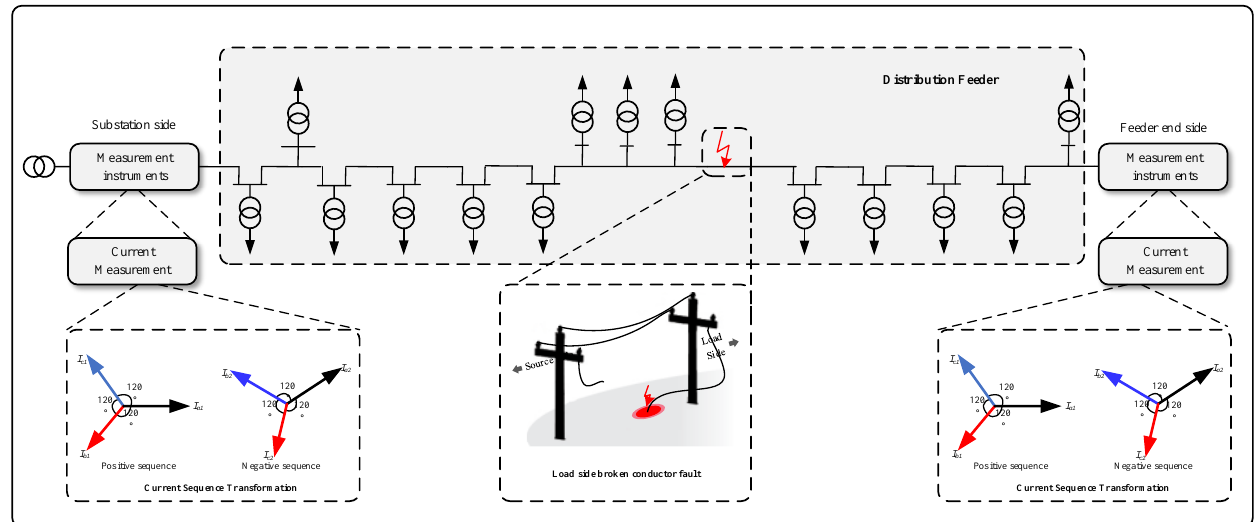
Figure 7. The flow chart of the proposed method.